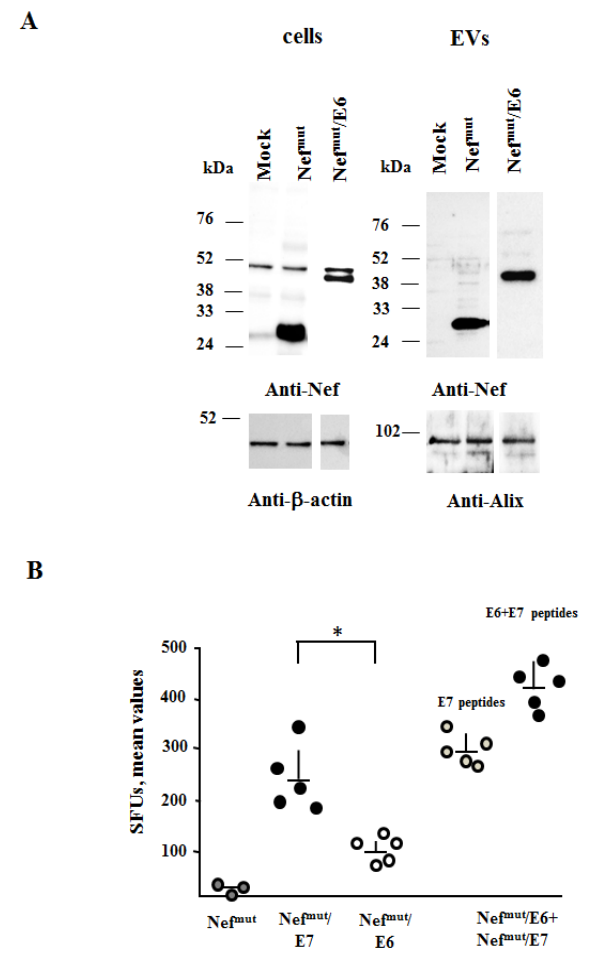
Figure 2. HPV16-E6 and -E7-specific CD8 + T cell immunity induced in mice co-injected with Nef mut /E6 and Nef mut /E7 DNA vectors. ( A ) Detection of Nef mut /E6 in HEK293T transfected cells and EVs. Western blot analysis of 30 µ g of lysates from cells transfected with DNA vectors expressing Nef mut /E6, and equal volumes of buffer where purified EVs were resuspended after differential centrifugations of the respective supernatants. As control, conditions from mock-transfected cells as well as cells transfected with Nef mut were included. Polyclonal anti-Nef Abs served to detect Nef mut -based products, while β -actin and Alix were markers for cell lysates and EVs, respectively. Molecular markers are given in kDa. The results are representative of three independent experiments. ( B ) CD8 + T cell immune response induced in C57 Bl/6 mice inoculated with the DNA vectors expressing Nef mut /E6 and Nef mut /E7 either singularly (10 µ g) or in combination (10 µ g each). As a control, mice were inoculated with 20 µ g of the Nef mut -expressing vector. At the time of sacrifice, 2.5 × 10 5 splenocytes were incubated o.n. with or without 5 µ g/mL of either unrelated, E6, E7, or E6+E7-specific peptides in triplicate IFN- γ EliSpot microwells. For each mouse, shown are the numbers of IFN- γ SFUs as mean values of triplicates after subtraction of values from wells treated with unrelated peptides. The E7-specific immune response was evaluated also in co-injected mice. Intragroup mean values + SD are also reported. * indicates statistically significant